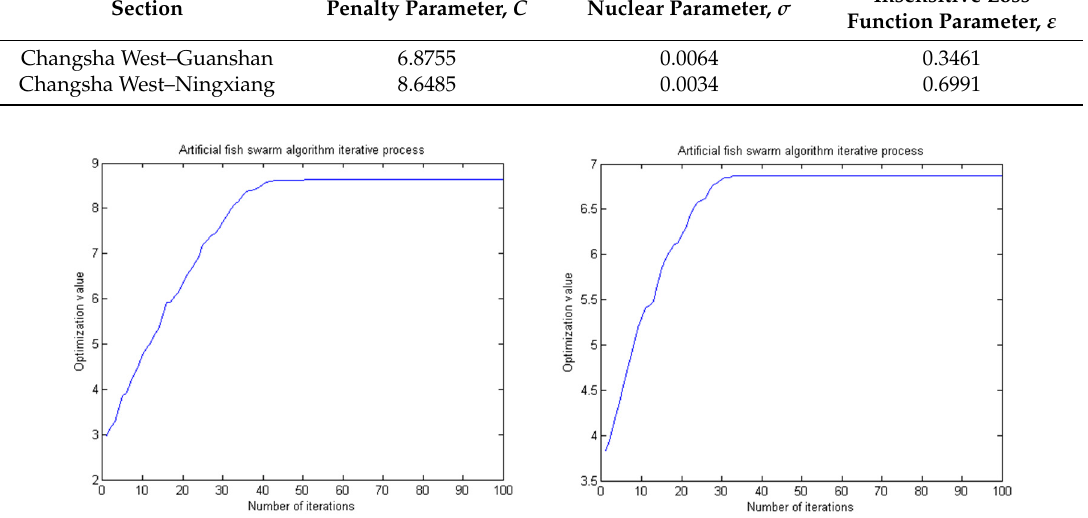
Figure 4. The parameter optimization curve.